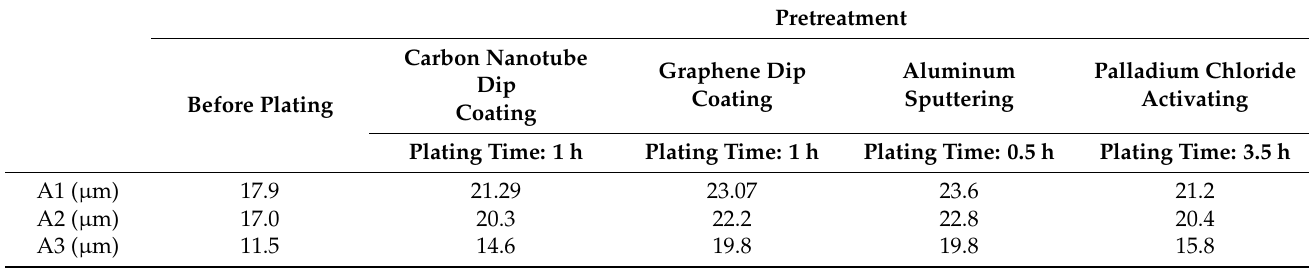
Table 2. Dimensional changes after electroless nickel plating using different pretreatments.